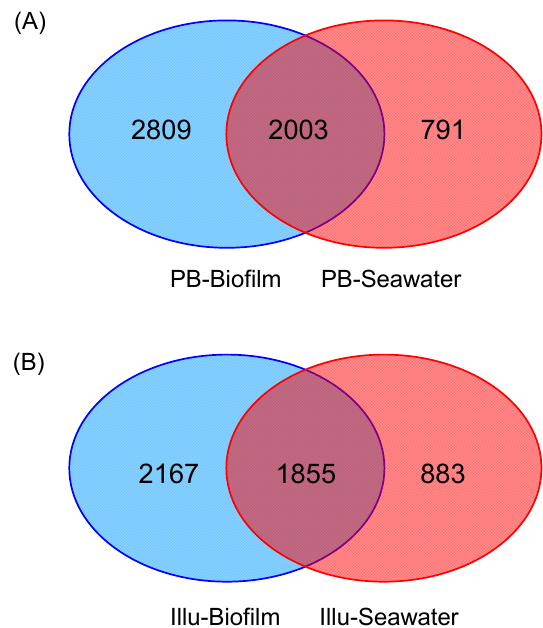
Figure 3. Venn diagrams showing the distribution of OTUs across biofilm and seawater samples. The three replicates were pooled together for analysis. ( A ) PacBio-sequenced samples. ( B ) Illumina-sequenced samples.